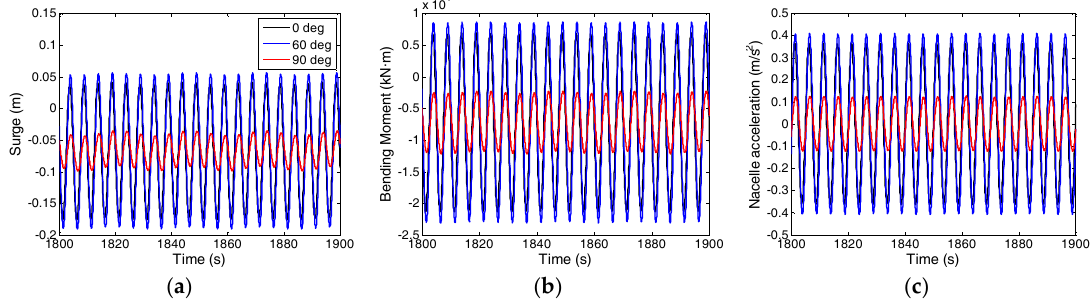
Figure 14. Time series of ( a ) surge; ( b ) tower base bending moment and ( c ) nacelle acceleration under the 5-s regular wave.